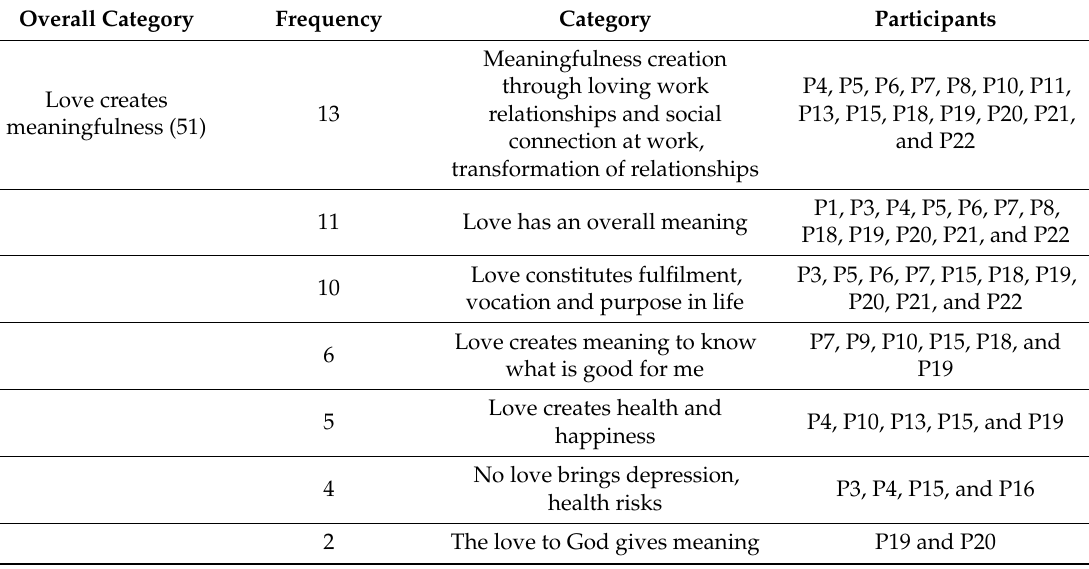
Table 4. Meaningfulness and love.